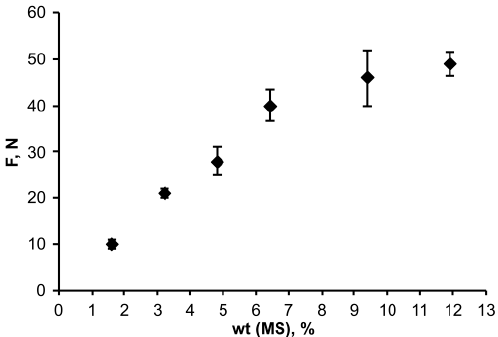
Figure 4. Dependence of the shift force on the concentration of silane in the OSTE-MS polymers. It turned out that the mechanical characteristics of the OSTE-MS polymers studied in this work were dramatically determined by the silane content in the polymer. With an increase in the silane concentration, there was a significant decrease in tensile strength and a decrease in Young’s modulus (Figure 5). Thus, at silane contents of 6.4, 12.1, and 17.1 wt.%, the values of tensile strength were 58, 19, and 13 MPa, and the values of Young’s modulus were 1.7, 0.4, and 0.1 GPa, respectively. Perhaps this is due to the fact that when MS interacted with TATATO, the TATATO had no more than two allyl groups, which led to an increase in linear fragments and a decrease in crosslinks (Figure S1).